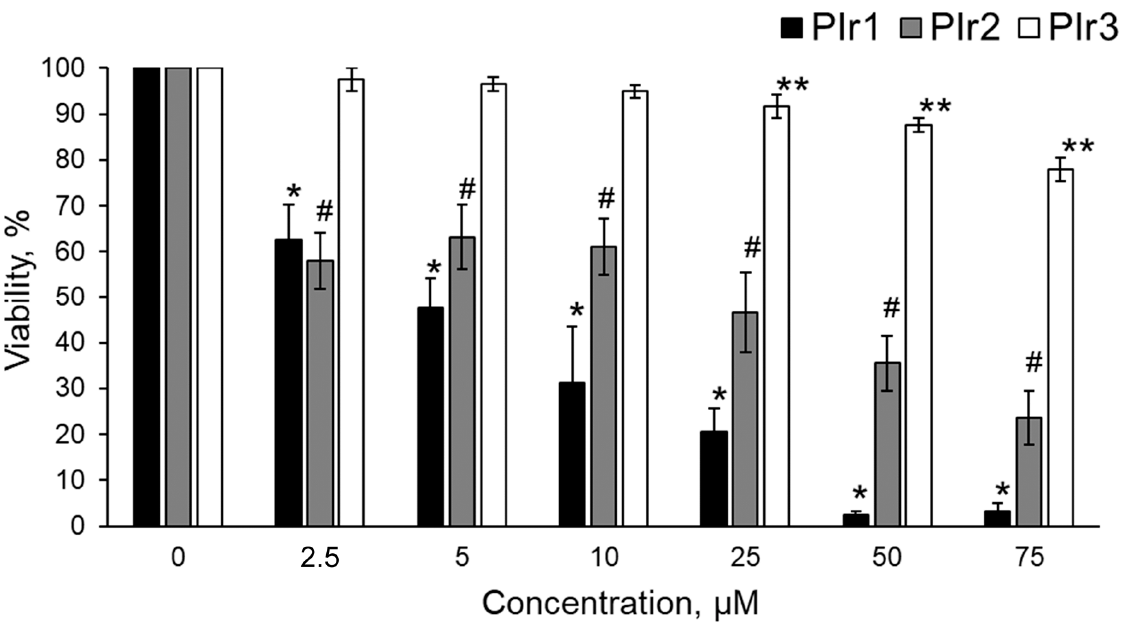
Figure 6. MTT assay for viability of CT26 cells after incubation with PIr1, PIr2, and PIr3 polymer probes. Mean ± SD. *, **, # p ≤ 0.05 vs. controls (0 µ М ). n = 3 repetitions.